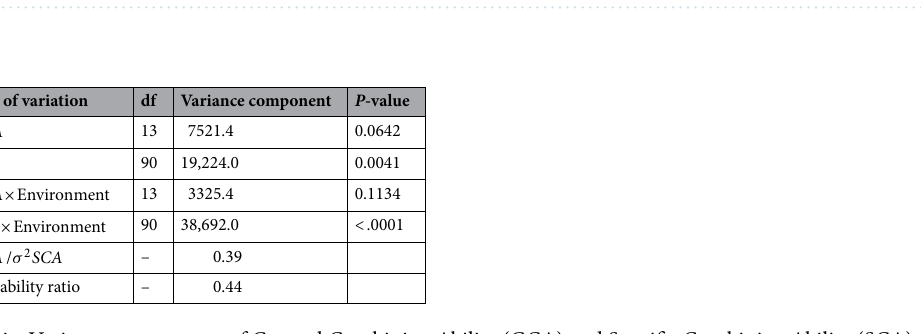
Table 3. Pairwise F st matrix for the seven marker groups. *, **, ***Significant at 0.05, 0.01, < 0.001 levels of probability, respectively.